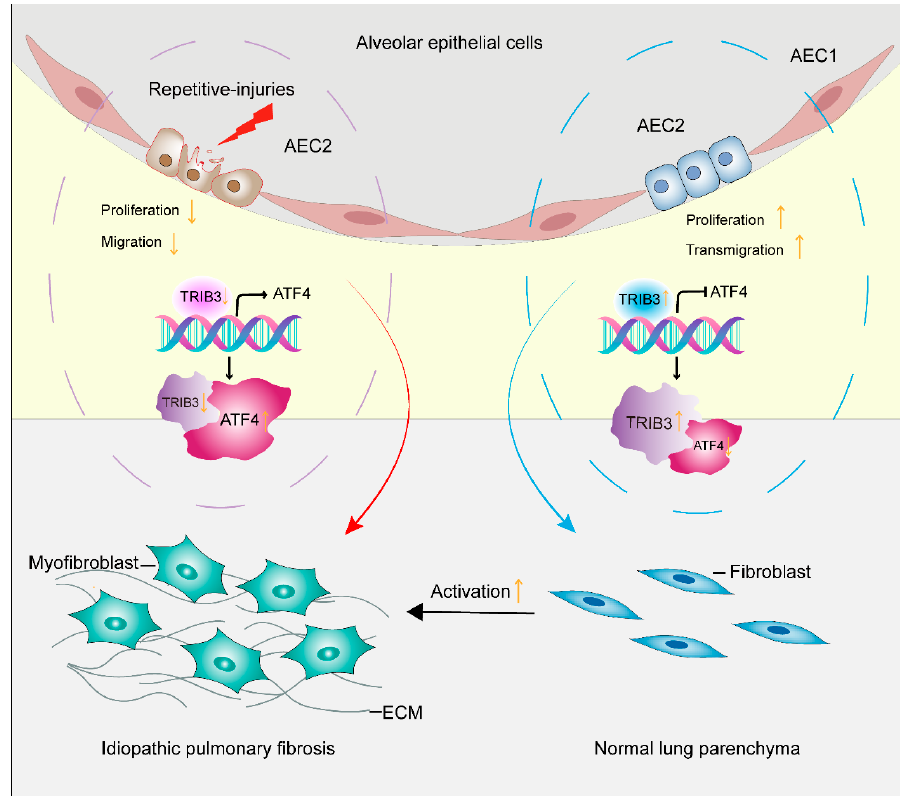
Figure 8. Antifibrotic mechanism of TRIB3 mediation of pulmonary fibrosis through inhibition of lung fibroblast activation. TRIB3 inhibits the transformation of pulmonary fibroblasts into myofibroblasts through interaction with ATF4 and inhibiting its expression.